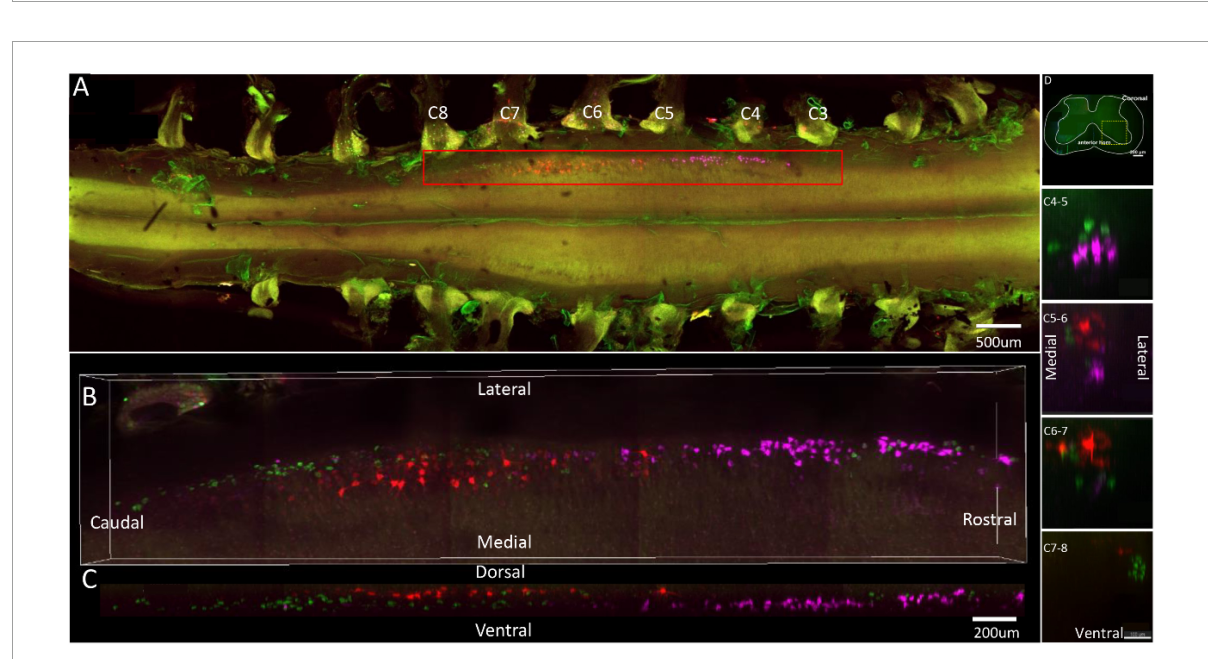
FIGURE2 Distribution characteristics of motor neurons targeting triceps (labeled by FG, red), extensor carpi radialis brevis (labeled by CTb-647, purple), and extensor digiti minimi (labeled by CTb-488, green). (A) Spatial images of multi-tracks in a holistic view. (B,C) The relative spatial positions of the motor neuron columns targeting different muscles in sagittal and corona viewing angles. (D) The schematic diagram of the distribution of different motor neuron columns in the anterior horn of the spinal cord. The yellow box that outlines the region of interest is amplified in the subpanels in panel (D) . The cross-sectional images are maximum projections of different parts of the spinal cord. The motor neurons innervating three muscles have little